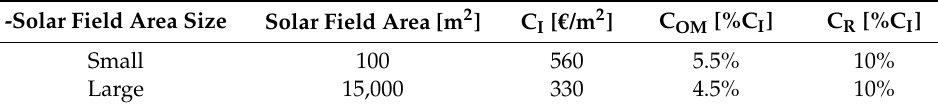
Table 6. PTC technology